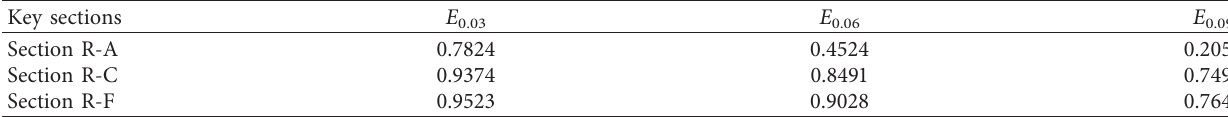
Table 8: The expected values for given earthquake